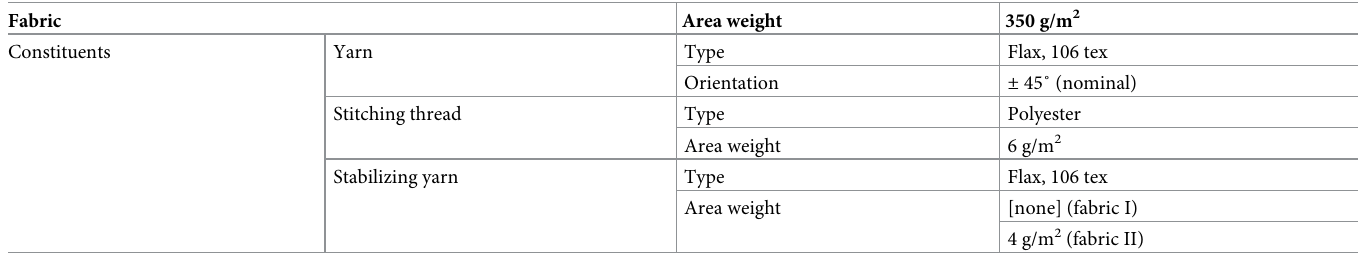
Table 1. Specifications of the used non-crimp biaxial flax fibre fabrics.